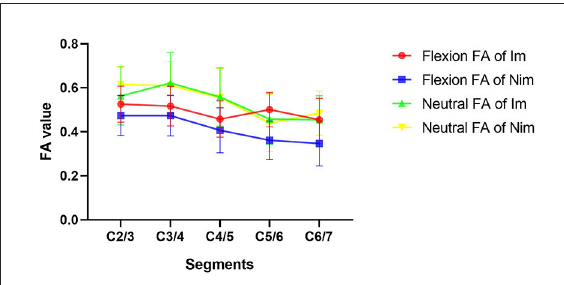
FIGURE3 Comparison of FA values between the two groups of patients. The figure shows the trends in variation of FA values from C2/3